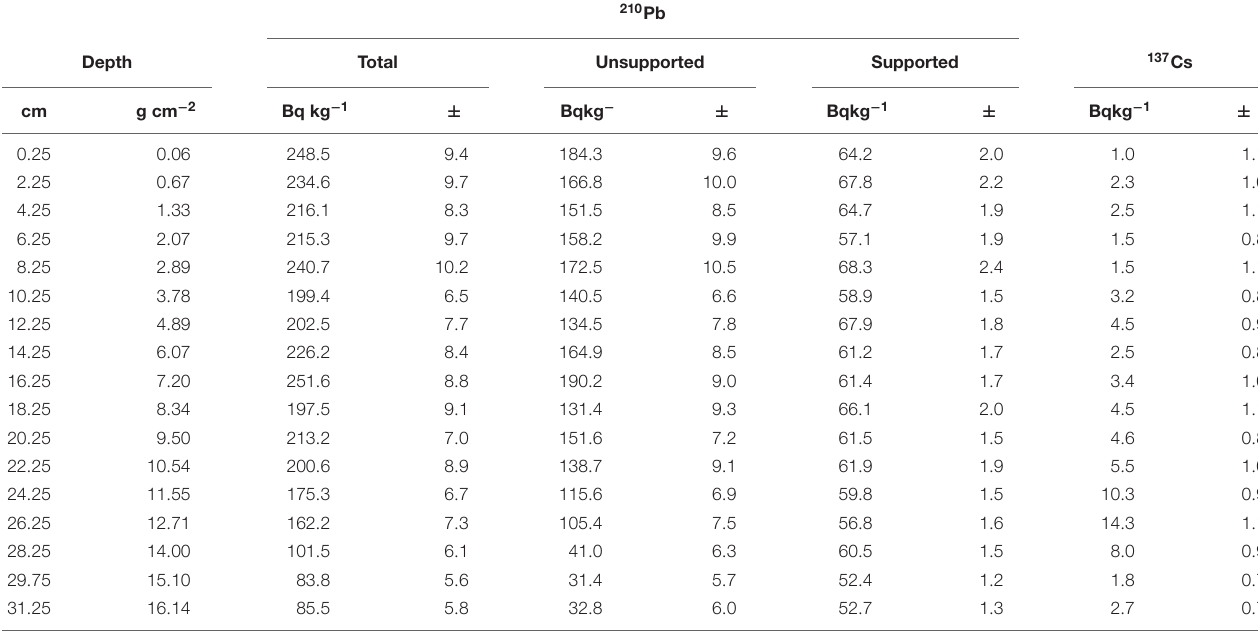
TABLE 1 | Fallout radionuclide concentrations in Sky Pond SKP corresponding to Figure 2 .